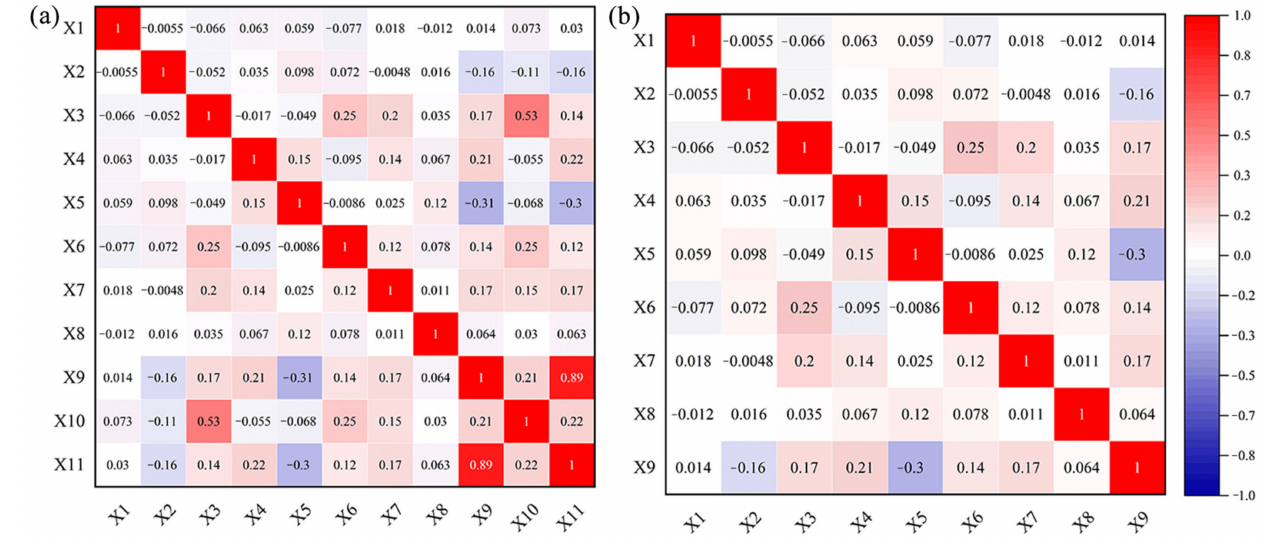
Figure 2. Correlation coefficient matrix. ( a ) is the correlation matrix of 11 variables, and ( b ) is the correlation matrix after excluding elevation (X10) and undulation (X11), where X1 to X11 represents land use type, lithology, distance to a river, profile curvature, plane curvature, NDVI index, distance to road, aspect, slope, elevation, and fluctuation,